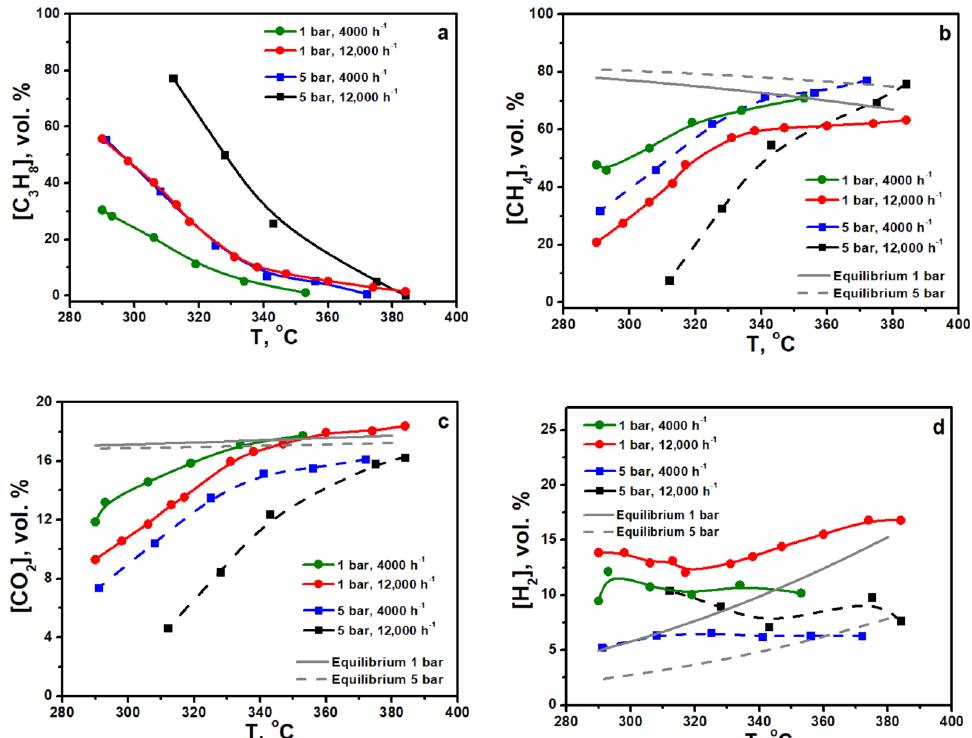
Figure 1. Temperature dependences of the outlet concentrations on a dry basis of propane ( a ), methane ( b ), carbon dioxide ( c ) and hydrogen ( d ) during propane pre-reforming. Experimental conditions: 220–380 °C, GHSV 4000 and 12,000 h −1 , 1 and 5 bar pressure and reaction mixture: 25 vol.% C 3 H 8 , 75 vol.% H 2 O. Concentrations of the gas components on the figure are given on the dry basis.